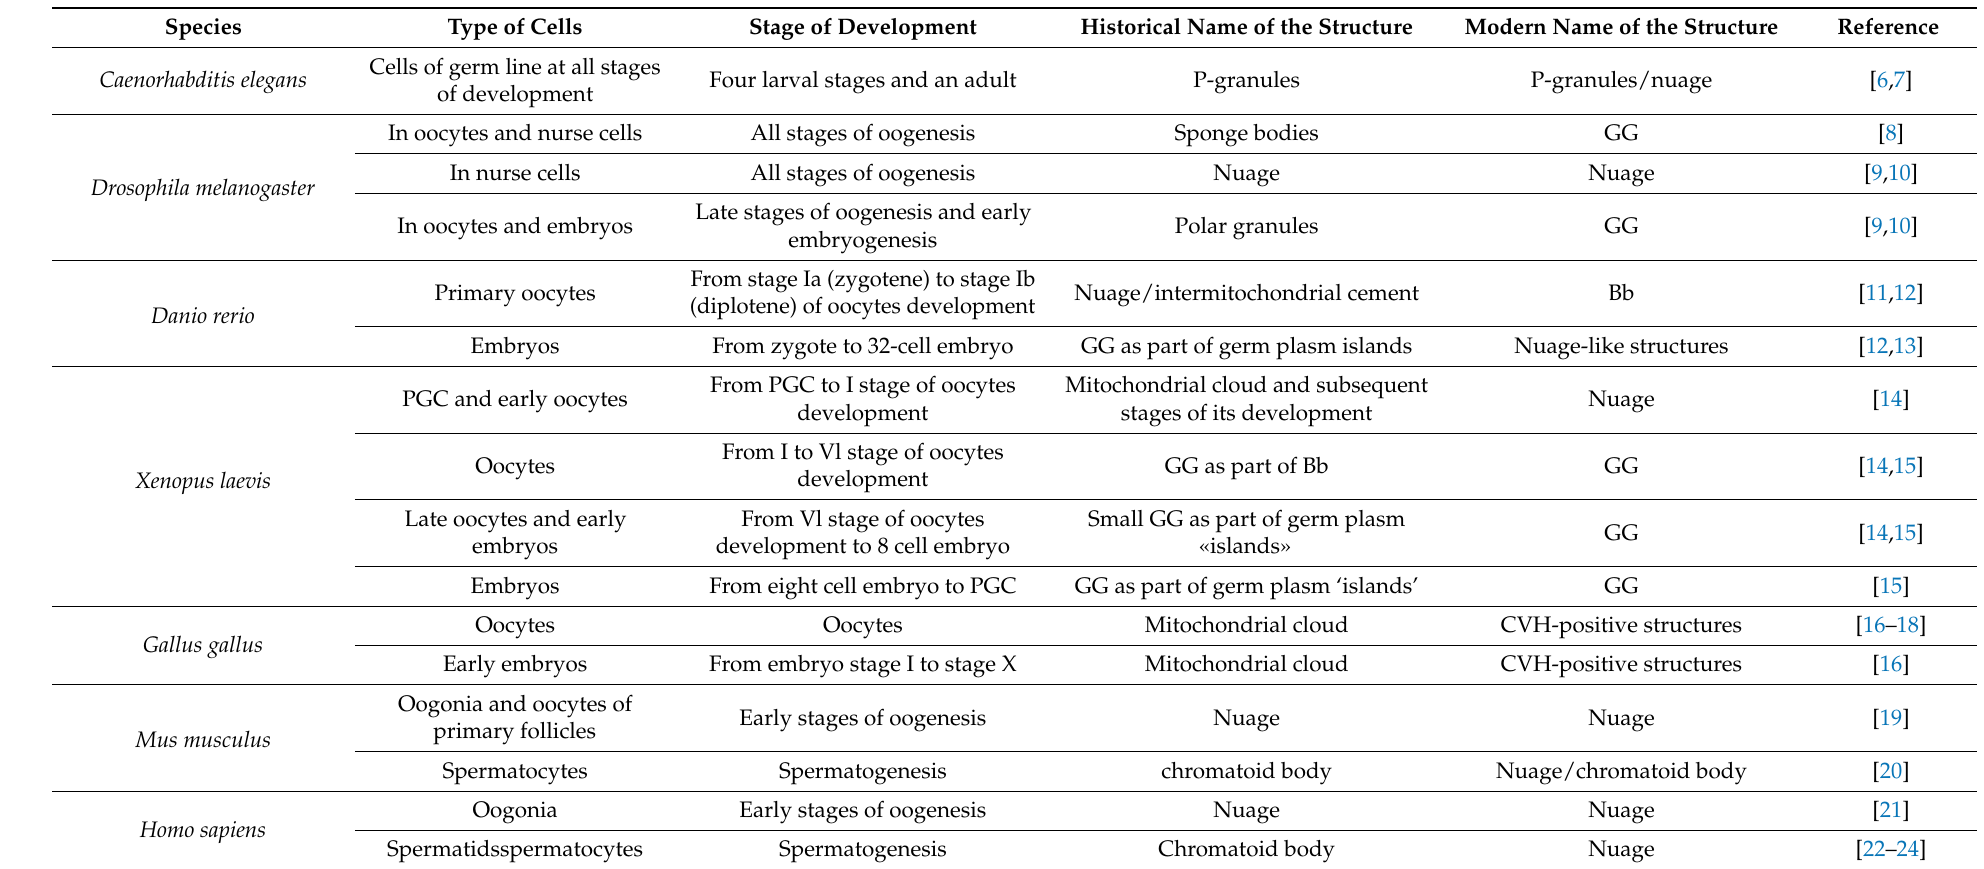
Table 1. Diversity of GG in different animal